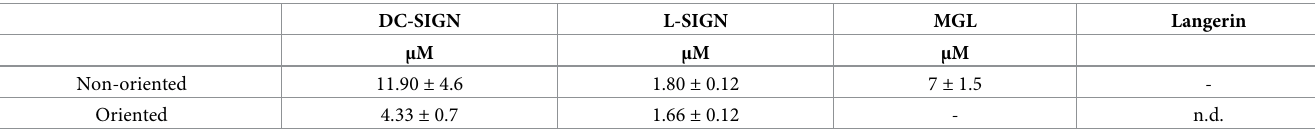
Table 1. Steady state determination of apparent K D for CLRs interaction with SARS-CoV-2 S protein.